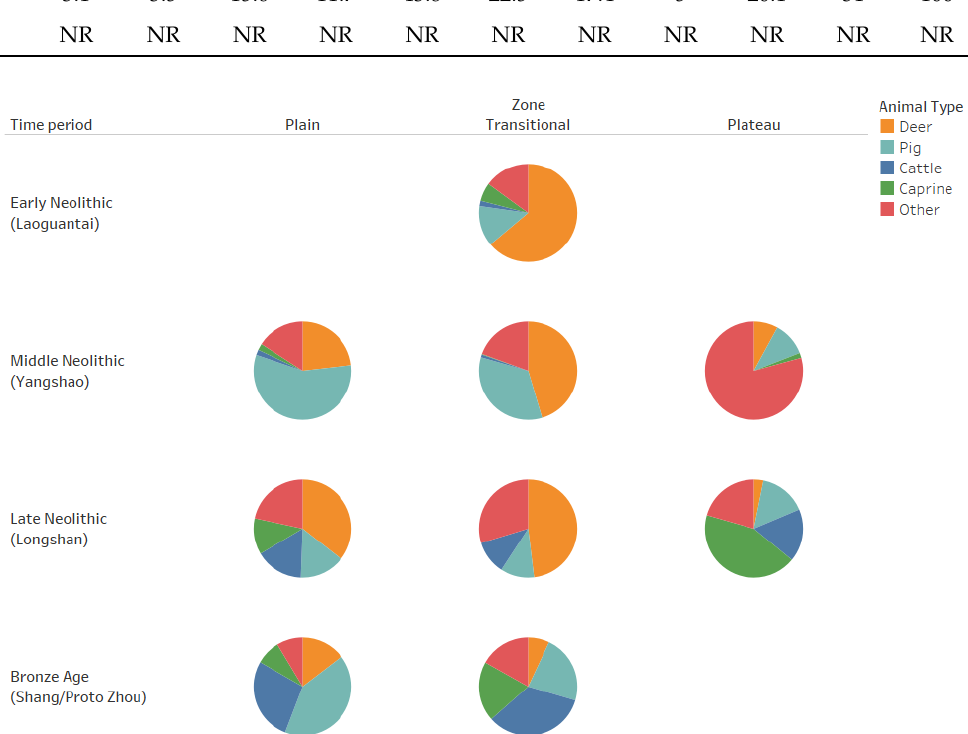
Figure 4. Pie charts showing the % NISP on average in each of the zones divided according to time period. (Drawn using tableau by F. Monteith).